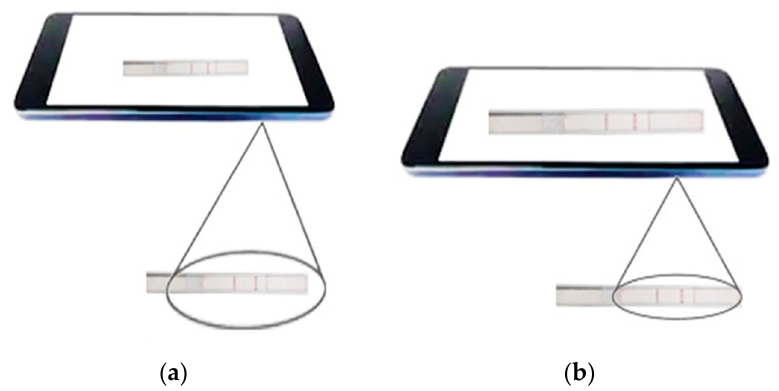
Figure 13. ( a ) Exact placement of the LFA strip under a smartphone camera and ( b ) an improper placement of the LFA strip—a larger field of view due to the proximity of the camera to the LFA strip.